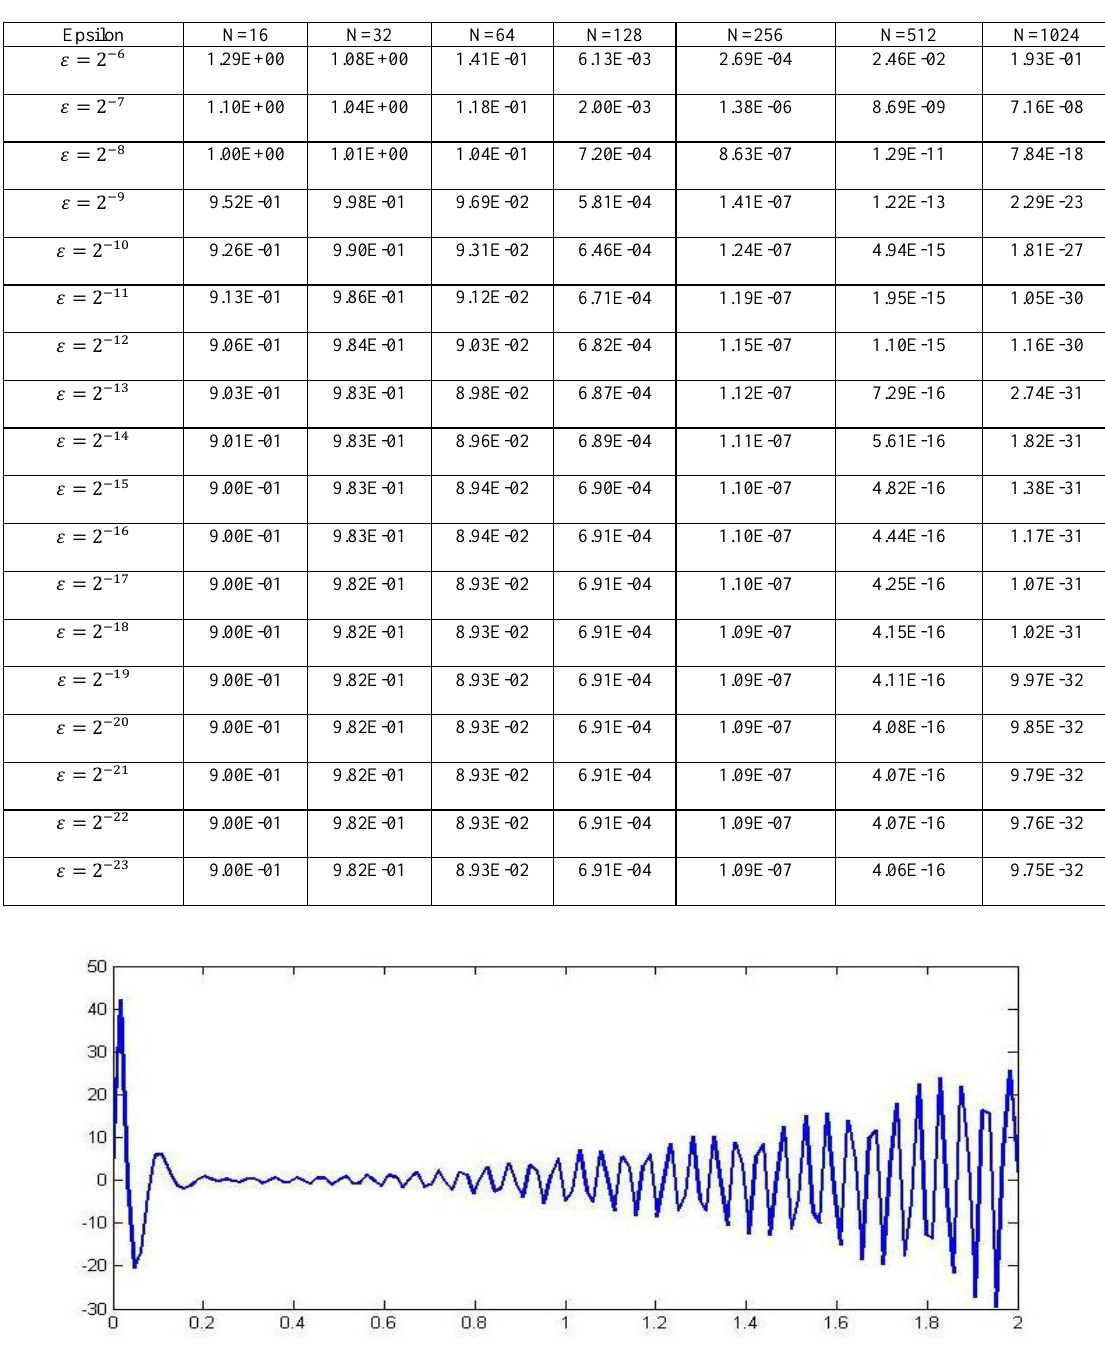
Table 1. Maximum absolute error of Example 1